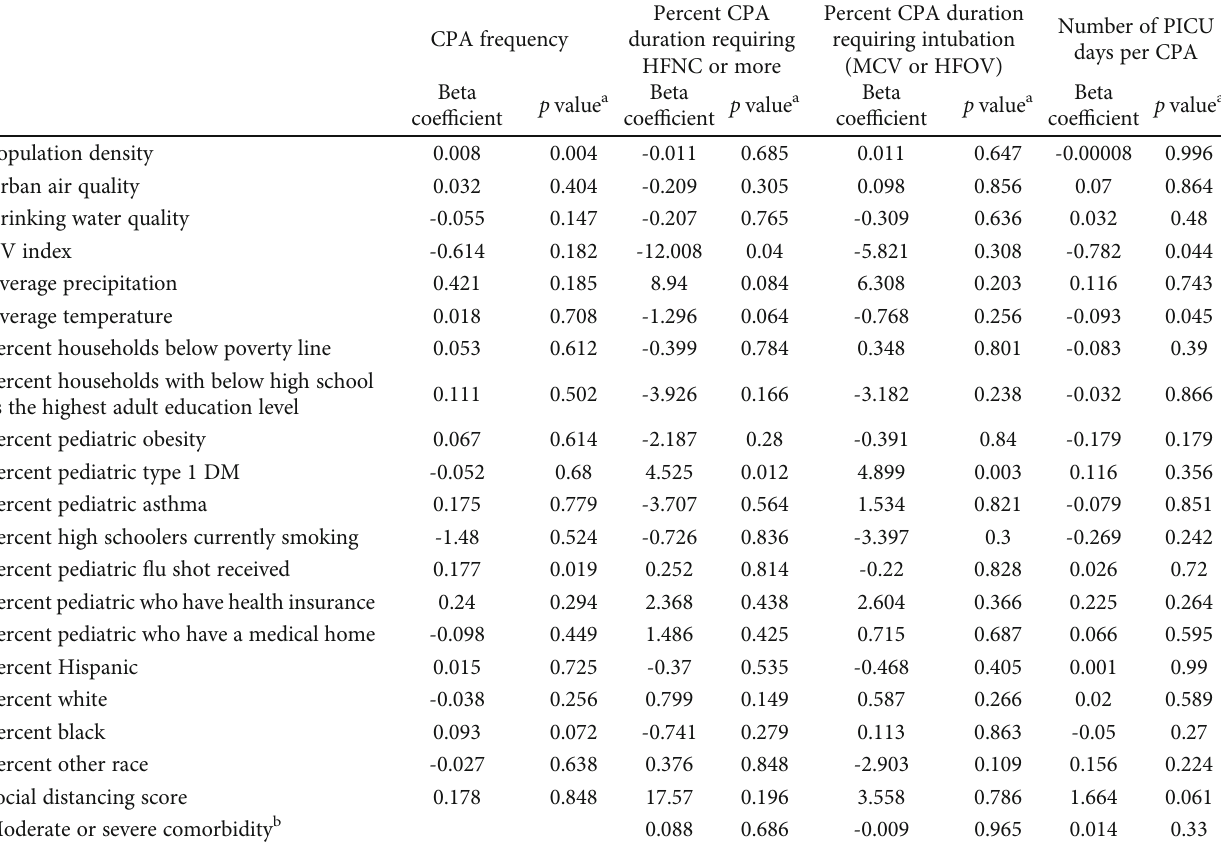
Table 2: Univariate analysis: association between pediatric population characteristics and COVID-19 positive admissions.